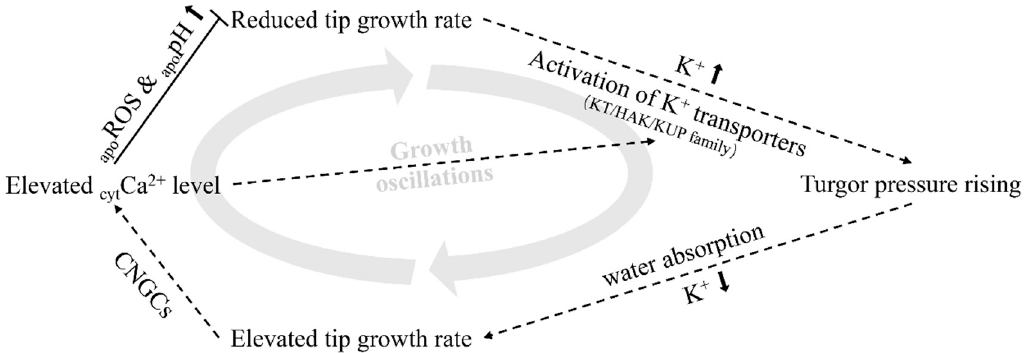
Figure 6. Working model: Activated K + transporters promote the assimilation of soil K + , elevating the cell turgor pressure and, leading to water absorption and growth acceleration. Then, the root hairs acquire Ca 2 + through cyclic nucleotide-gated channels (CNGCs), where the increase in Ca 2 + level triggers apoplastic ROS ( apo ROS) production, alkalizes apoplastic pH ( apo pH), and restricts tip growth; likely also activating K + transporters to prepare for the next round of growth oscillations.